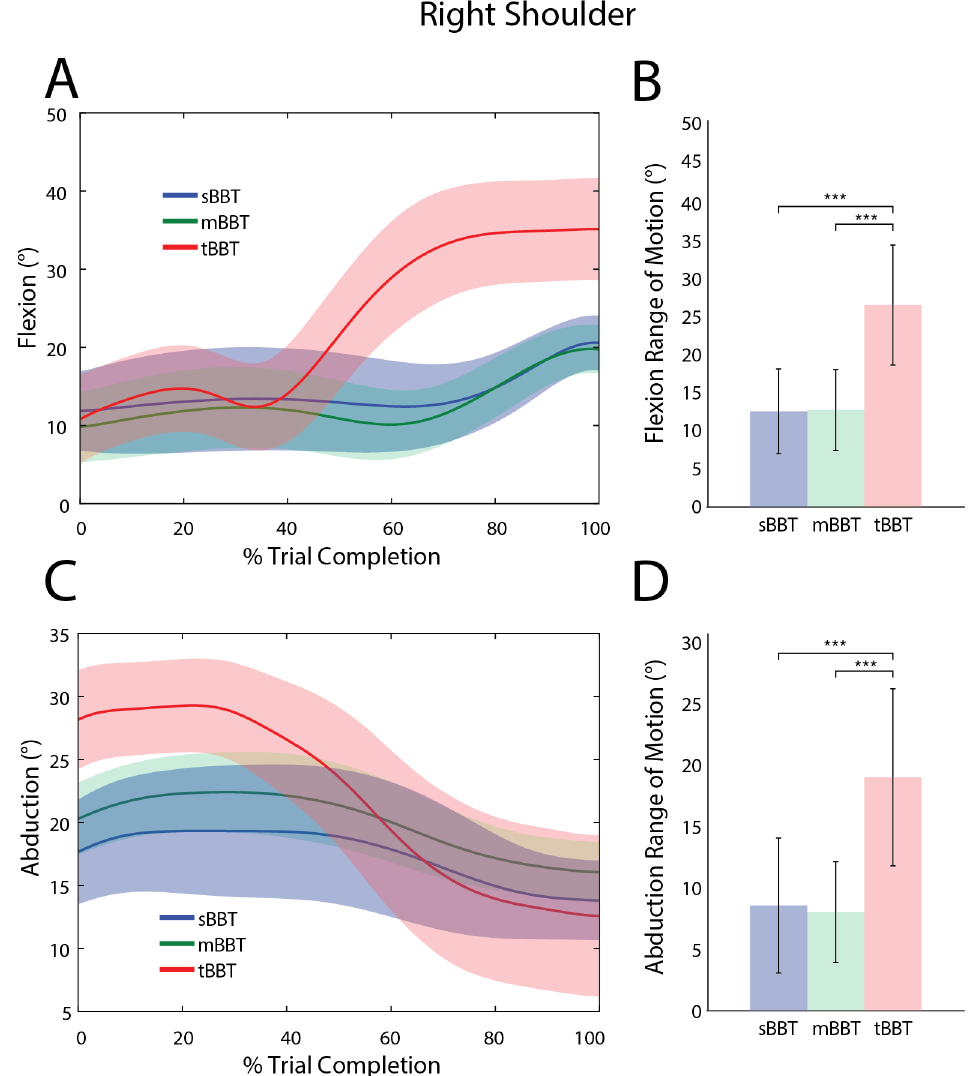
Fig 5. Kinematic trajectoriesand RoM of the right shoulder. Kinematictrajectories and RoM of the right shoulderfor the sBBT (blue), mBBT (green), and tBBT (red). (A)Shoulderflexionand (C) shoulderabduction trajectories for each test. (B) ShoulderflexionRoM and (D) shoulderabductionRoM for each test.